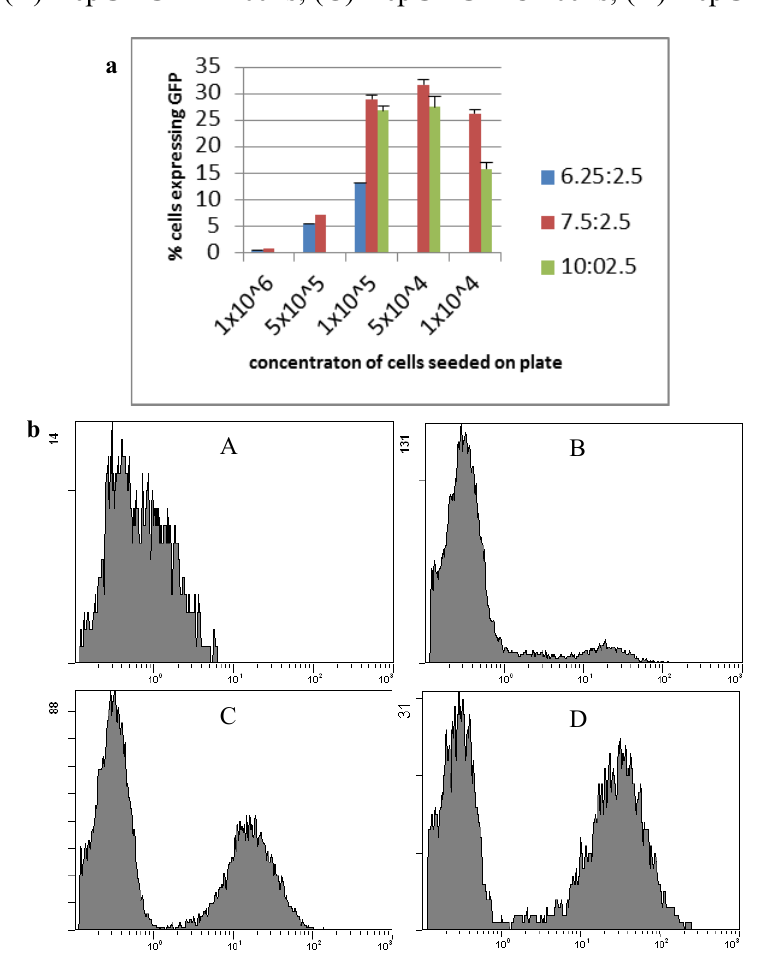
Figure 1. Transfection of HepG2 cells using lipofectamine LTX and pcDNA3-EGFP. ( a ) HepG2 cell line transfection optimisation of lipofectamine LTX ratio and cell seeding concentrations counted by the average number of cells expressing GFP. Blue : a ratio of 6.25 µL lipofectamine LTX to 2.5 µg plasmid; Red : a ratio of 7.5 µg lipofectamine LTX to 2.5 µg plasmid; Green : a ratio of 10 µL lipofectamine LTX to 2.5 µg plasmid ( n ≥ 3, mean ± standard deviation); ( b ) Flow cytometry of HepG2 cells expressing GFP. ( A ) HepG2 parental cells; ( B ) HepG2 GFPB1 cells; ( C ) HepG2 GFPC2 cells; ( D ) HepG2 GFPC1